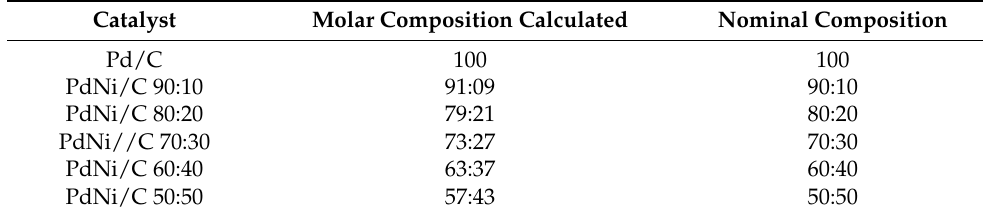
Table 2. Molar composition of Pd/C and PdNi/C nanocatalysts derived from XRD data. Catalyst